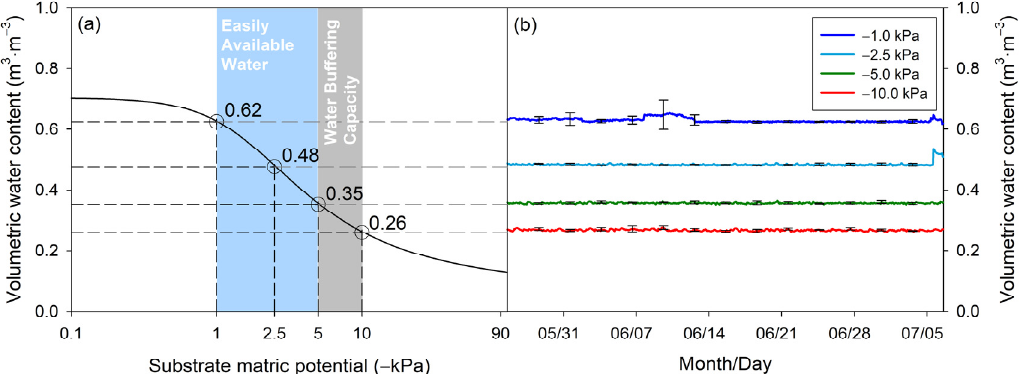
Figure 2. Irrigation threshold determined by an FDR sensor-based automated irrigation system installed in containers with English lavender ( Lavandula angustifolia ) cuttings. ( a ) Moisture retention curve of the substrate (Sunshine Mix #5, SunGro); ( b ) Changes in substrate volumetric water content (VWC, m 3 ·m − 3 ). The VWC thresholds were set at − 1.0, − 2.5, − 5.0, and − 10.0 kPa, corresponding to 0.62, 0.48, 0.35, and 0.26 m 3 ·m − 3 , respectively, within the easily available water and water buffering capacity. The error bars indicate standard deviation.